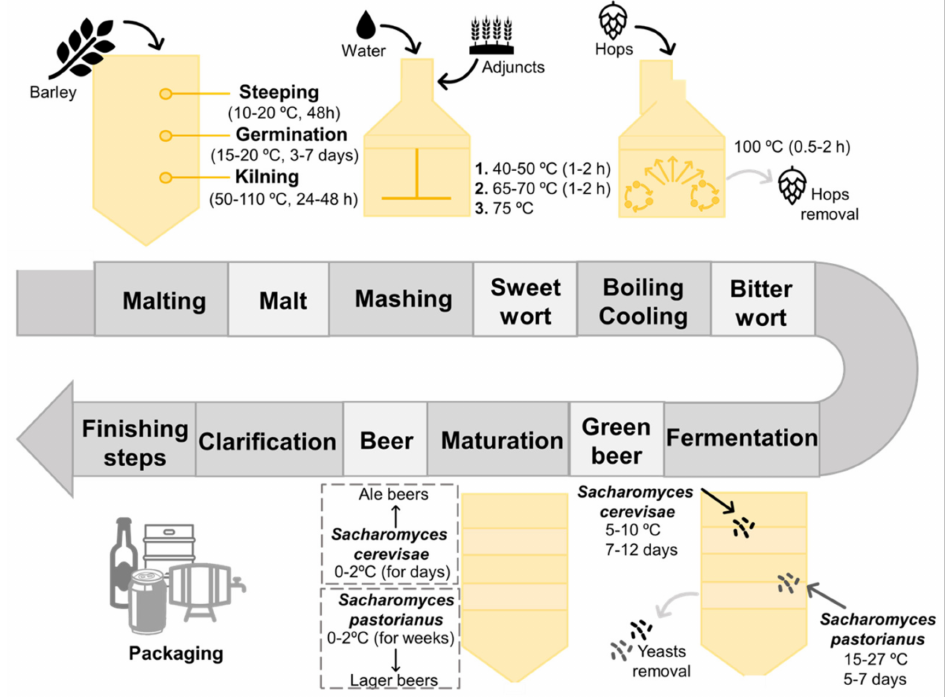
Figure 1. Schematic overview of the brewing